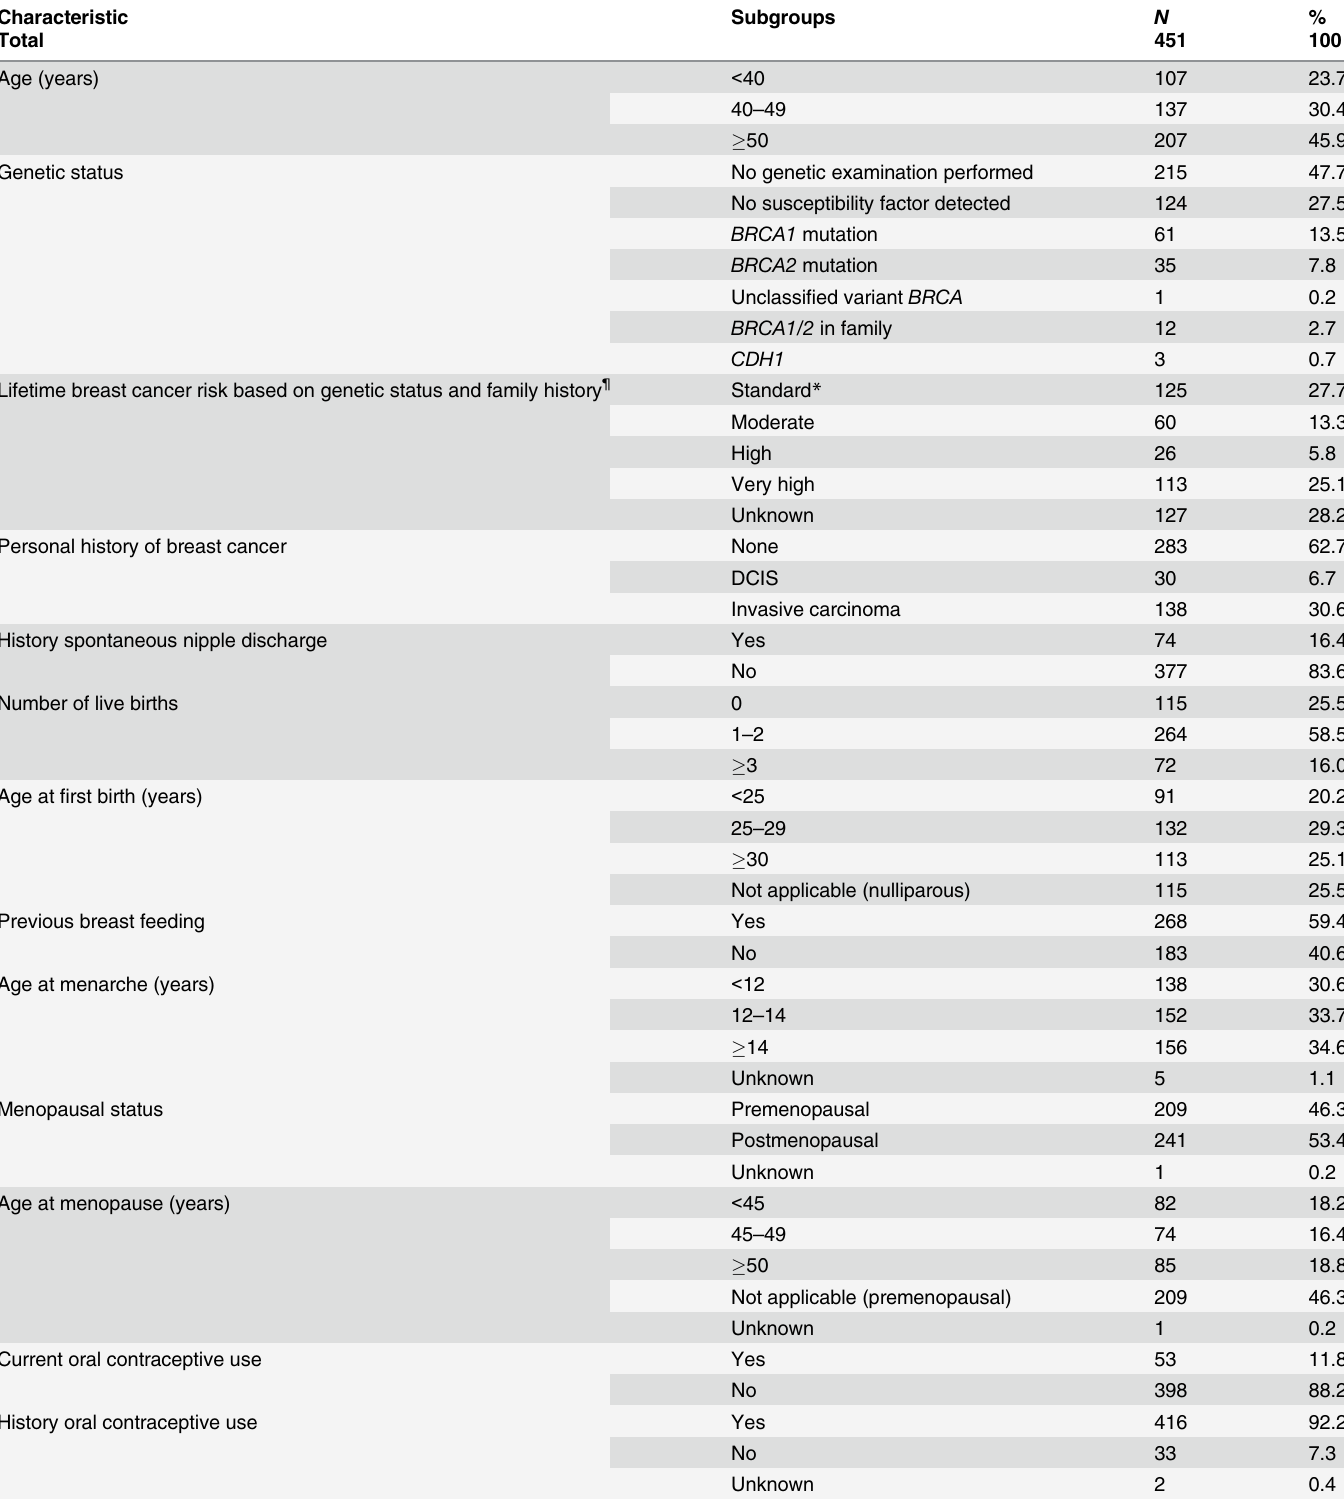
Table 1. Baseline characteristics of 451 women at increased breast cancer risk undergoing (repeated)